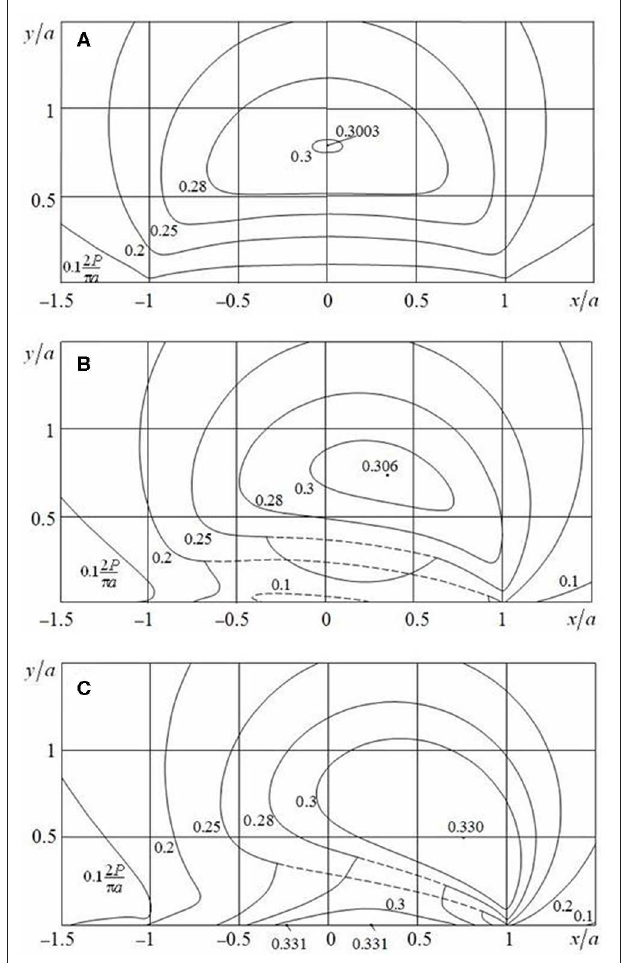
FIGURE 3 | Distribution of maximum tangential stress τ max in the cases of (A) smooth contact ( µ 0 0, Q / P 0), (B) contact with slip and adhesion = = ( µ 0 0.25, Q / P 0.15), and (C) sliding contact ( µ 0 = = TABLE 1 | Points with the largest value of maximum tangential stress.